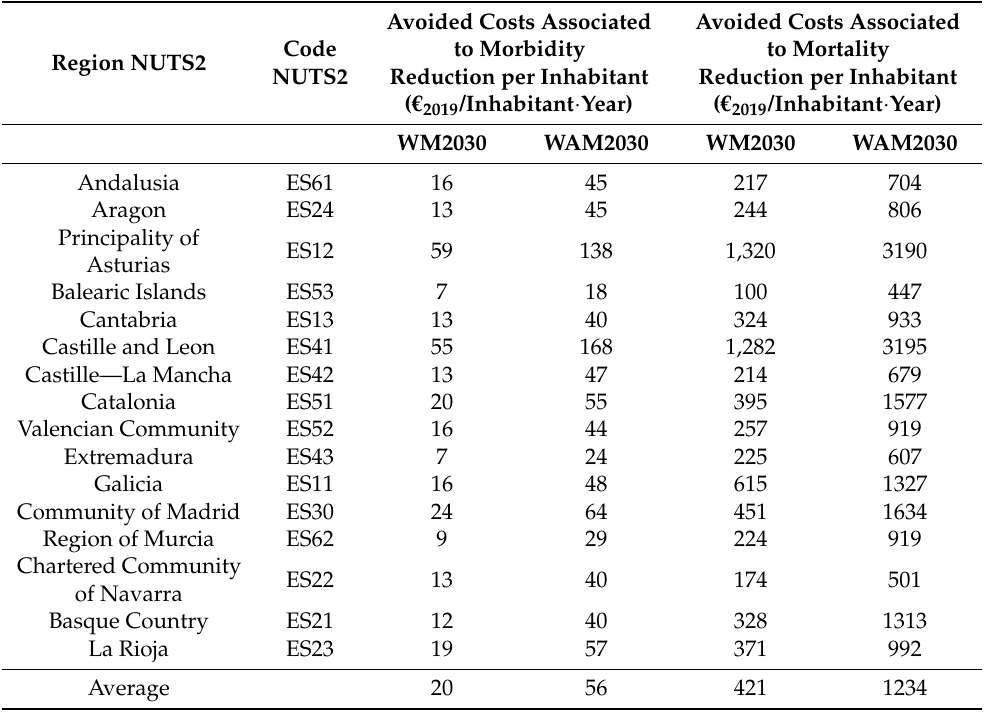
Table 4. Avoided costs associated to reduction of impacts on health per capita for the scenarios WM2030 and